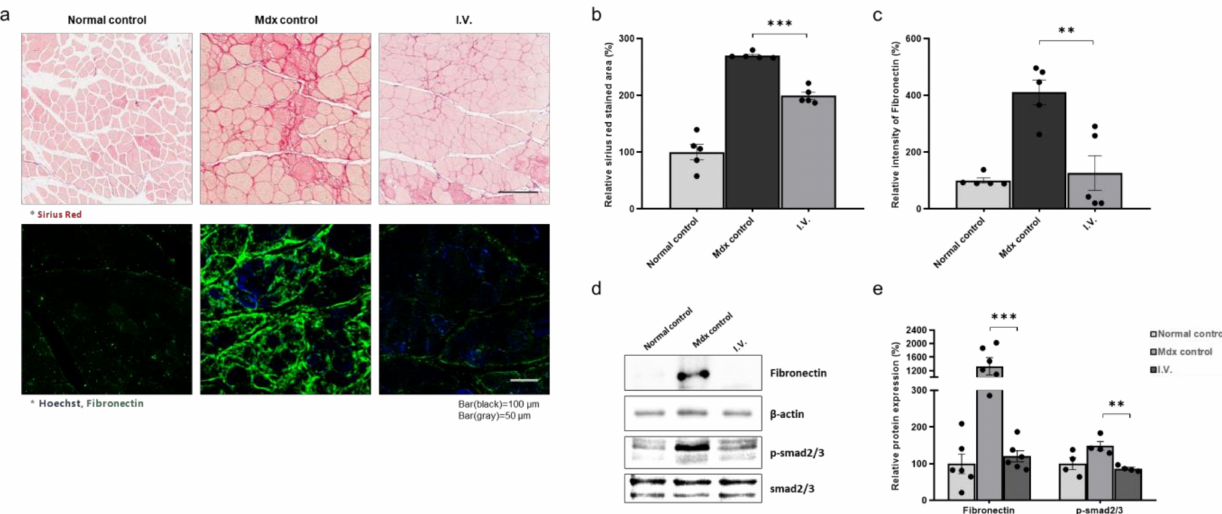
Figure 4. Anti-fibrotic effect of Wharton’s jelly-derived mesenchymal stem cells in the skeletal muscle of mdx mice ( a ) Representative images of Sirius Red staining for fibrosis evaluation and immunohistochemistry for fibronectin detection. ( b , c ) Quantitative measurements were performed in ImageJ, and the data are expressed as the mean ± SEM. Bars with different superscripts indicate significantly different values. ( d ) Representative western blot for fibronectin and p-smad2/3. β -actin was used as a loading control. Phospho-smad2/3 was normalized to total smad2/3. ( e ) Quantification of fibronectin and phospho-smad2/3 protein levels. The data are expressed as the mean ± SEM. Bars with different superscripts indicate significantly different values (** p < 0.01, *** p <